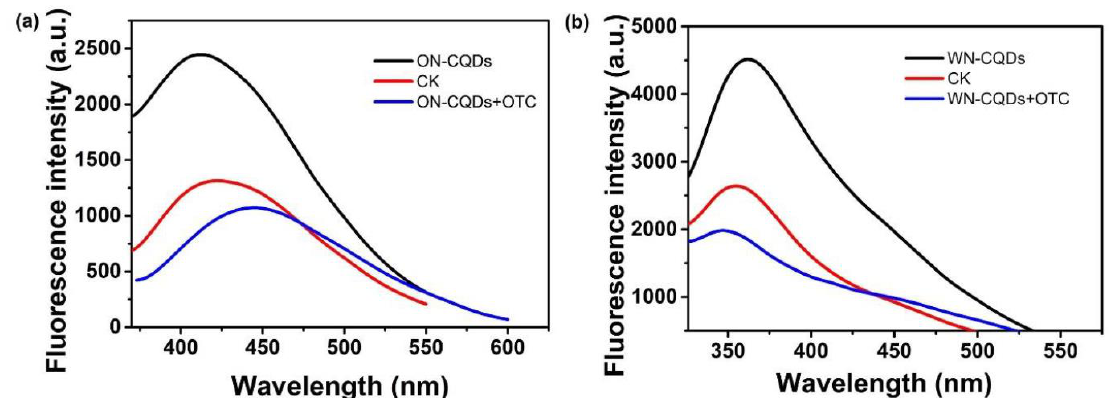
Figure 8. Fluorescence emission spectra of N-CQDs, CK (N-CQDs + deionized water), N-CQDs + OTC. ( a ) ON-CQDs ( λ ex = 320 nm); ( b ) WN-CQDs ( λ ex = 280 nm).